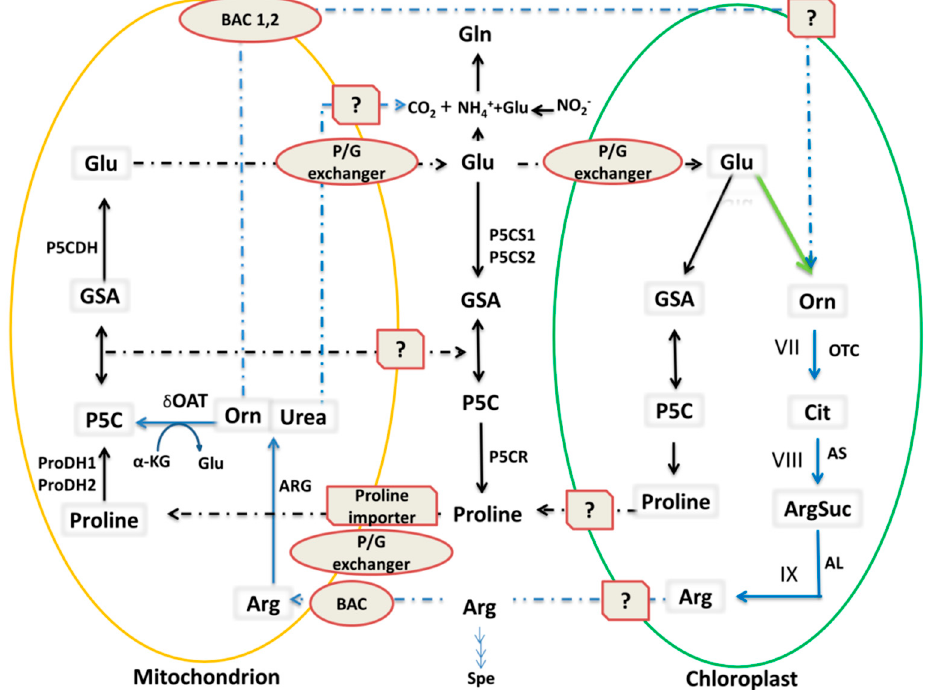
Figure 2. Proline, ornithine, and arginine metabolism and transport in plants. An illustration of the components of the proline (Pro) and arginine (Arg) metabolic pathways that have been identified to date. Data were taken from previously published papers [53–58]. Most data were obtained from the model plant A. thaliana , but it is hypothesized that this pathway is the same in related plant species. The Pro metabolic pathway is depicted by black lines, the blue lines show the Arg pathway, and the green line shows the ornithine (Orn) pathway, which is further described in Figure 3. Solid lines show cellular pathways while the dotted lines show the intracellular transport of metabolic products. Enzyme transporter proteins are depicted in blue. Glu: glutamate; Arg: arginine; Orn: ornithine; Gln: glutamine; ARG: arginase; Cit: citrulline; OTC: ornithine transcarbamylase; AS: arginosuccinate synthetase; AL: arginosuccinate lyase; ProDH: Pro dehydrogenase; Spe: spermidine; BAC: basic amino acid transporter involved in Arg and Orn exchange; ?: predicted transporters.